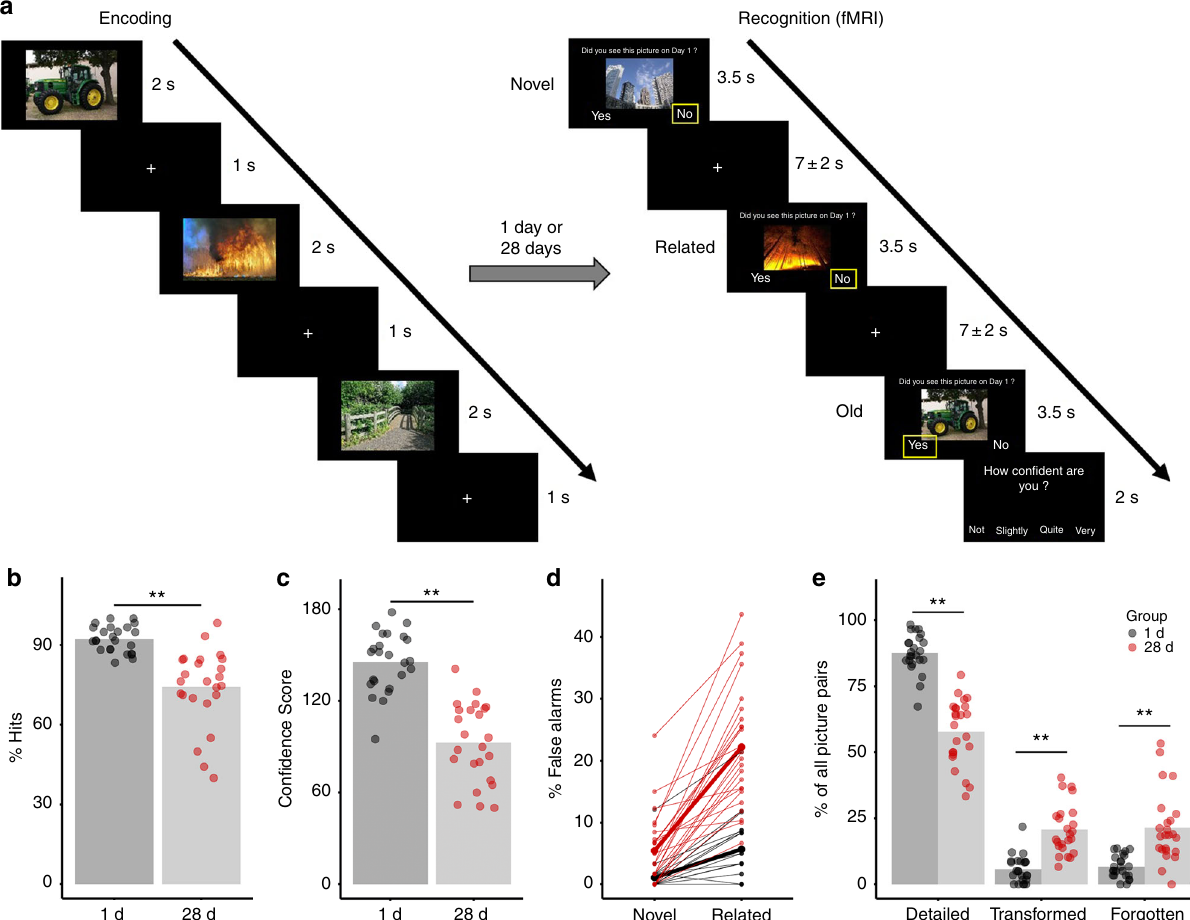
Fig. 1 Task and behavioral results. a Schematic overview of the picture encoding task (experimental day 1) and recognition task (experimental day 2). Images courtesy of Andreas Praefcke (tractor), Morio (skyscrapers), USDA (wild fi res), and Acabashi (footbridge). b Percentage of Hits: participants in the 28 d group showed signi fi cantly less hits (main effect Group: F (1,46) = 33.57, p = 5.89e − 07, generalized η 2 = 0.377, n = 48). c Con fi dence Score: participants in the 28 d group had a signi fi cantly lower Con fi dence Score (main effect Group: F (1,46) = 63.33, p = 3.41e − 10, generalized η 2 = 0.550, n = 48). d Percentage of FA for related pictures and novel pictures: the increase in FA from the 1 d group to the 28 d group was more pronounced for related pictures than novel pictures (Picture Type × Group interaction: F (1,46) = 36.31, p = 2.65e − 07, generalized η 2 = 0.155, n = 48). e Percentage of picture pairs: the 28 d group compared to the 1 d group showed fewer detailed pairs (main effect Group: F (1,46) = 102.96, p = 2.55e − 13, generalized η 2 = 0.607, n = 48), more forgotten pairs (main effect Group: F (1,46) = 26.88, p = 4.72e-06, generalized η 2 = 0.335, n = 48) and critically also more transformed pairs (main effect Group: F (1,46) = 45.15, p = 2.41e − 08, generalized η 2 = 0.425, n = 48). ** p <